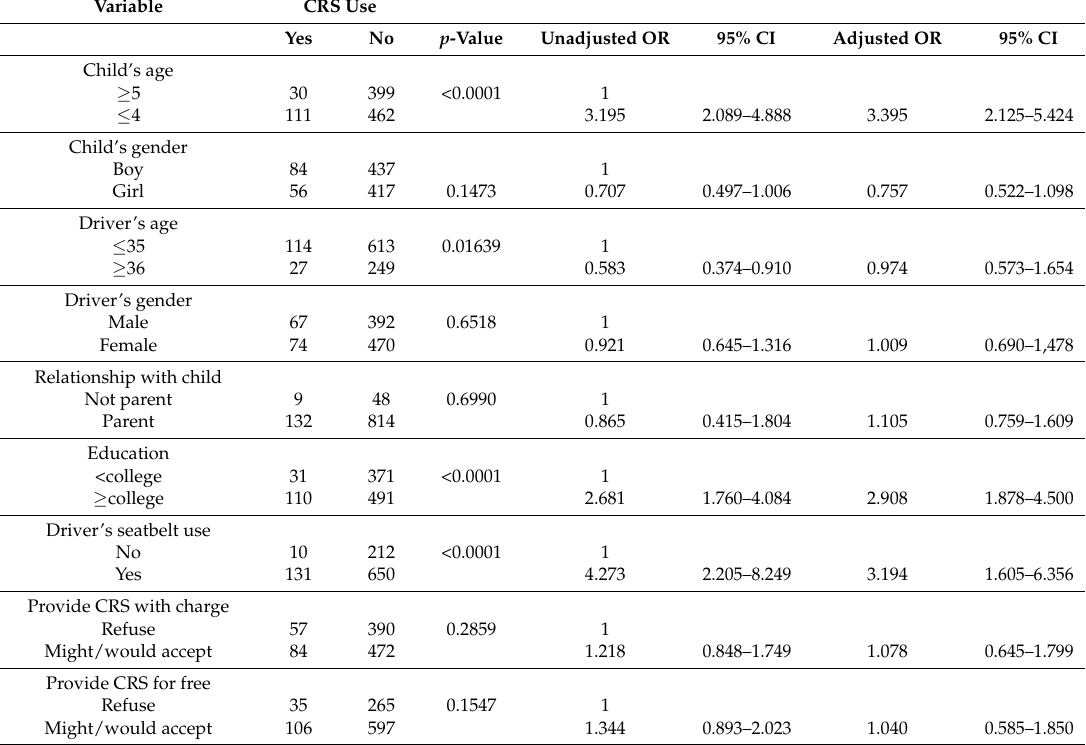
Table 3. Unadjusted and adjusted odds of CRS use a